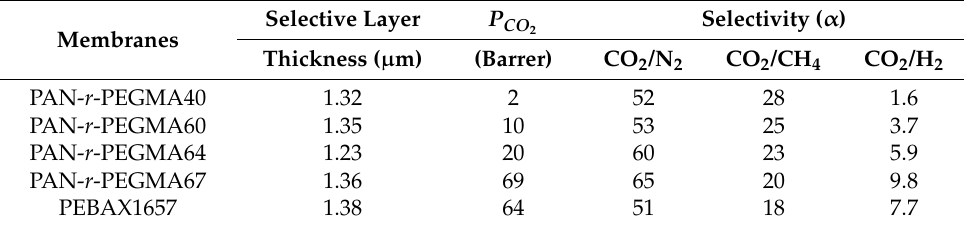
Table 2. Membrane thickness, CO 2 gas permeability and selectivity.